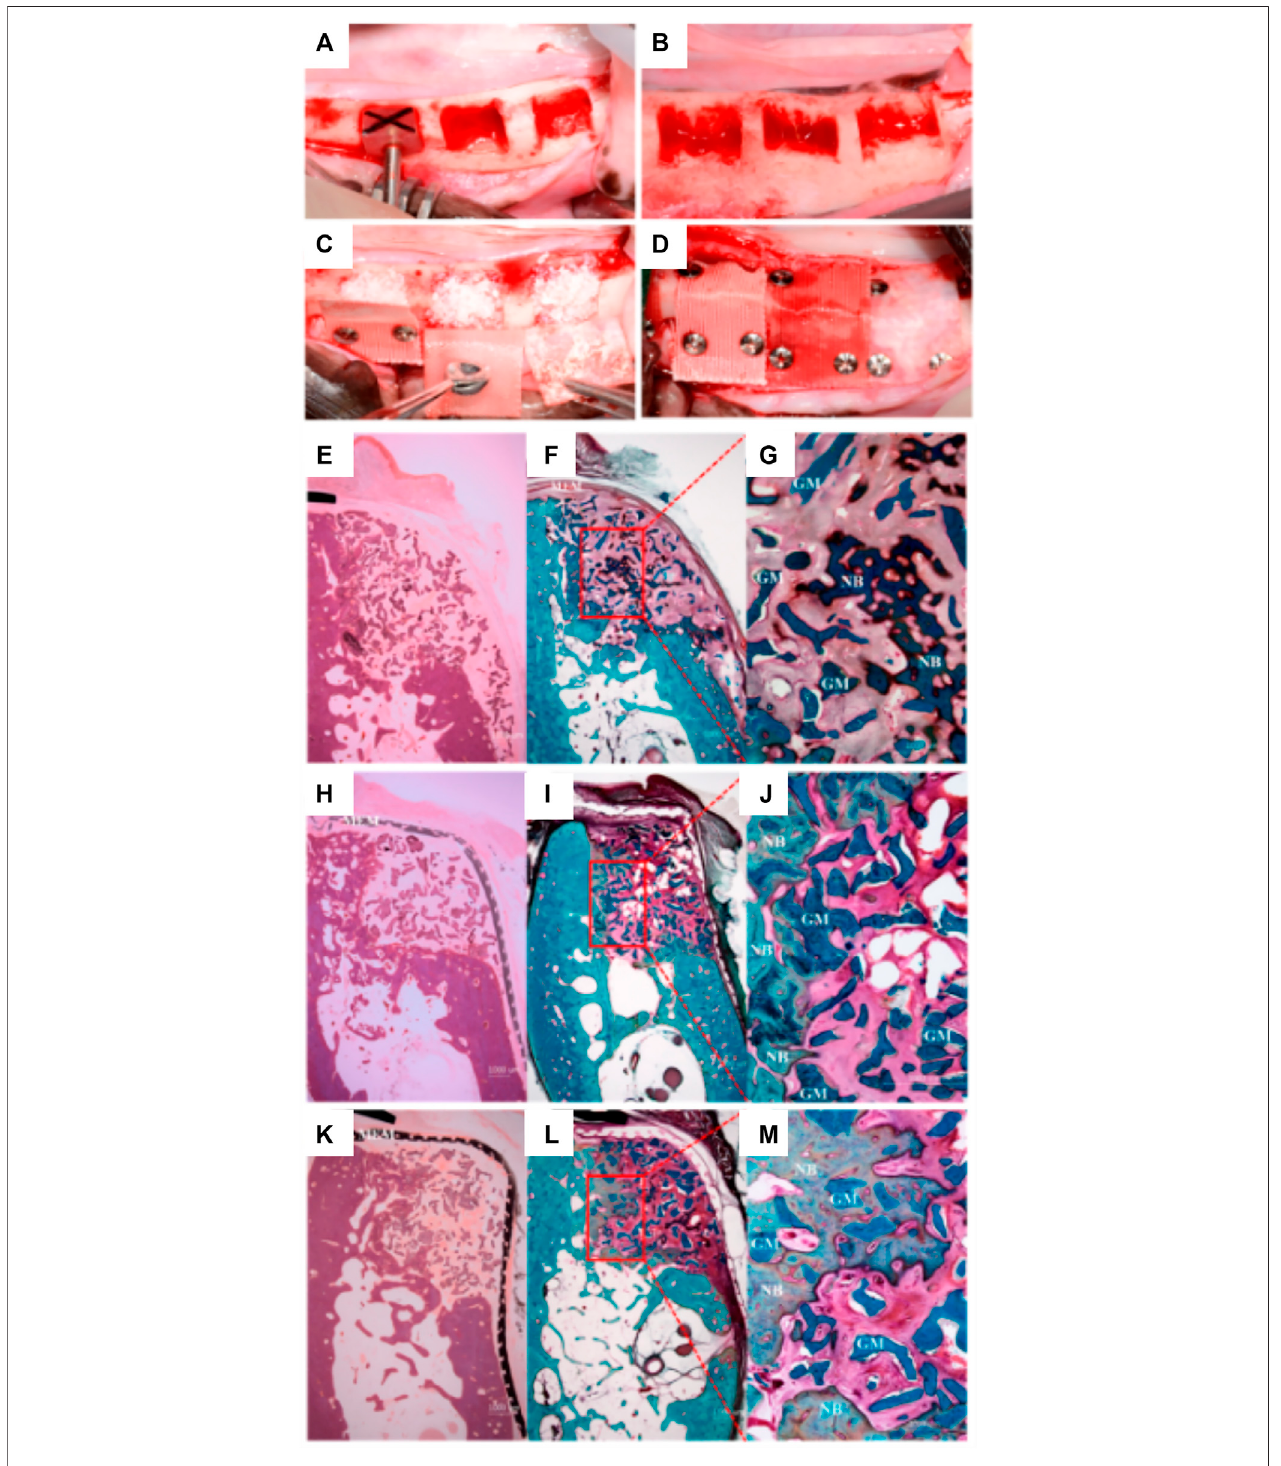
FIGURE10| ComparisonofPCLandPLC-BTCP3D-printedmembranestoacollagenmembraneinacaninemandibulardefect. (A,B) :Surgicalpreparationofthe site inordertocreate standardized defects, (length: 7 mm, height:5 mm,depth:5 mm) (C) :Implantationofthebone graftingparticulatematerials, (D) :placementofthe various membranes fi xed using titanium screws. Tissue morphology as demonstrated using Hematoxylin and eosin (E, H, K) stain and Goldner Trichrome stain (F,G,I,J,L,M) for collagen (E – G) , PCL (H – J) , PCL/b-TCP membrane (K – M) . Reproduced with permission from (Shim et al., 2017).